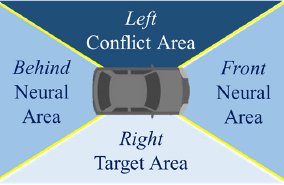
Figure 8. Risk distribution around the ego vehicle.